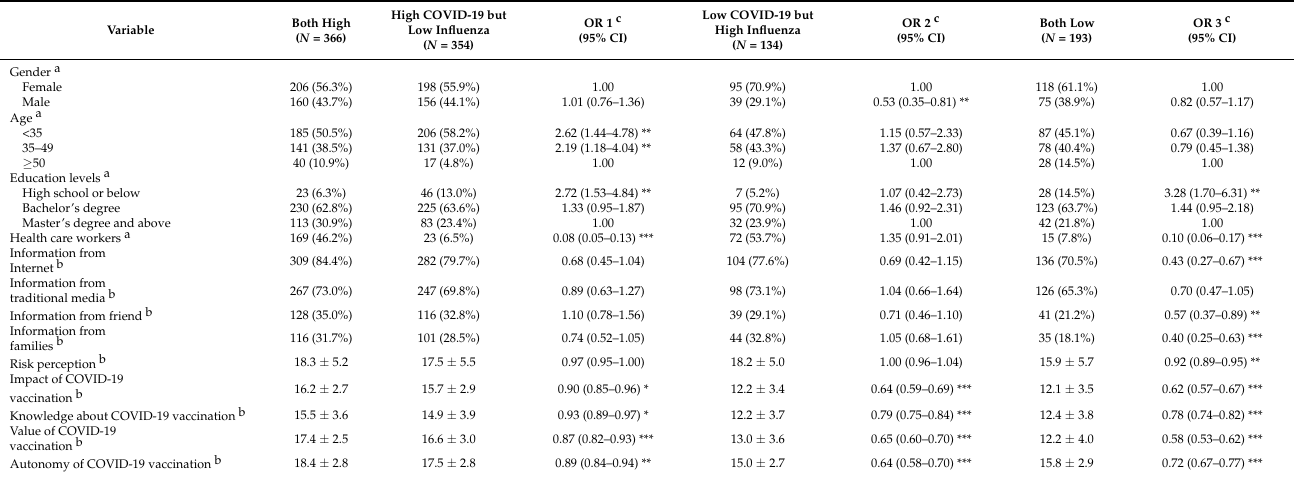
Table 3. Comparison of sociodemographics, sources of information, perceived risks, and cognitive appraisals of vaccination against COVID-19 between various latent classes of motivation to get vaccinated against COVID-19 and previous seasonal influenza vaccination: multinomial logistic